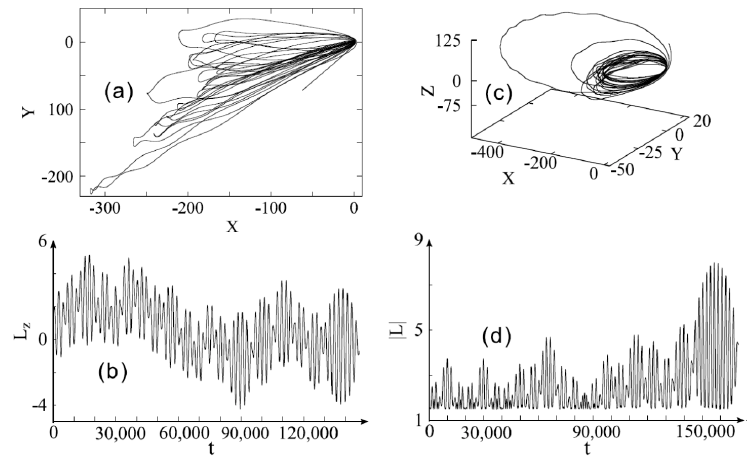
Figure 8. Trajectories of Rydberg electron (frames a , c ) and the evolution of its angular momentum L (frames b , d ) for the 10P-state ( n 0 = 10, l 0 = 1) of the hydrogen atom. For two-dimensional (2D) motion of an electron in the { X , Y }-plane (frame a ), frame b shows the projection L Z of the momentum L on the z -axis, orthogonal to the motion plane { X , Y }. For three-dimensional (3D) motion (frame c ), frame d shows | L| .